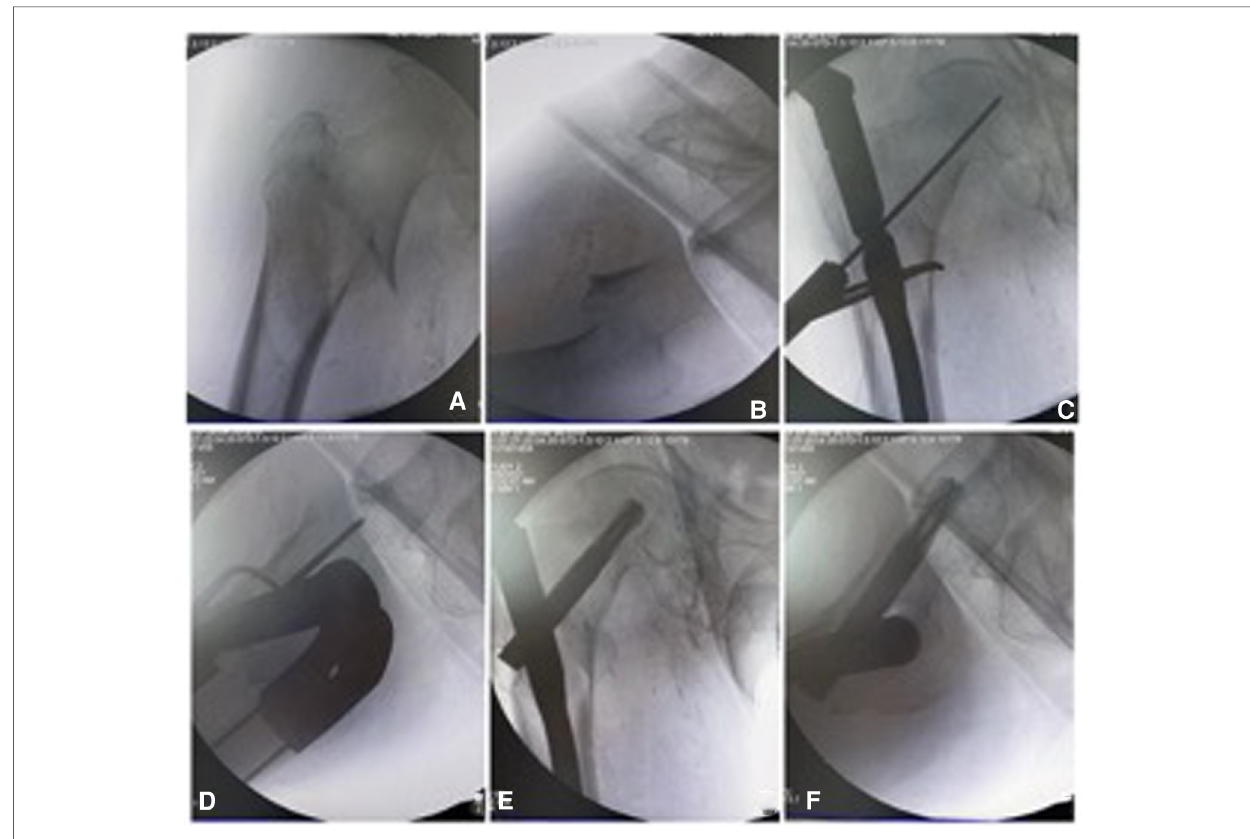
FIGURE 6 The right-angle forceps was used for reduction of the medial arch fragments. ( A,B ) Under axis traction, anteroposterior and lateral images show the medial arch fragment displaced anteromedially. ( C,D ) the right-angle forceps were used to pry the medial arch fragment, which was con fi rmed under anteroposterior and lateral images. ( E,F ) The helical blade was inserted and anatomical reduction of the medial arch was achieved.